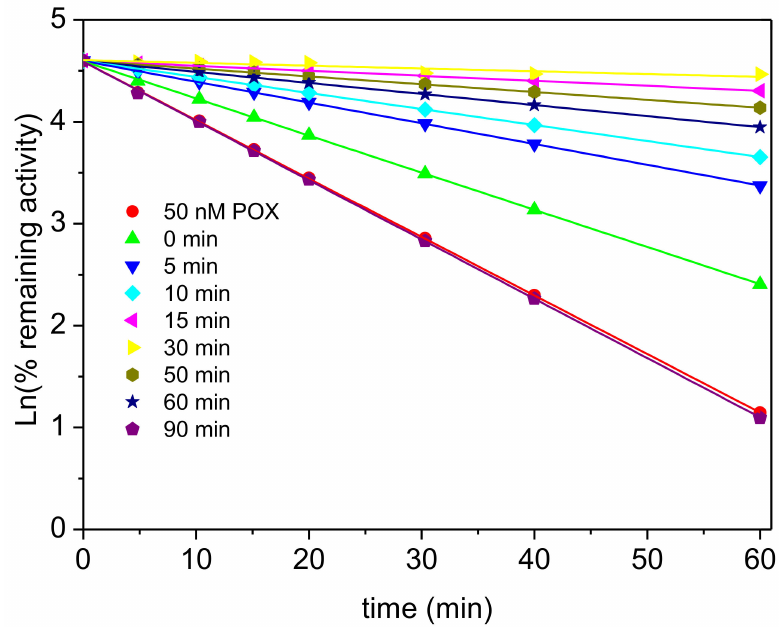
Figure 13. First-order inhibition of AChE by 50 nM paraoxon after pre-incubation of the enzyme in the presence of 10 nM TFK up to 90 min, pH 8.0, 25 ◦ C.